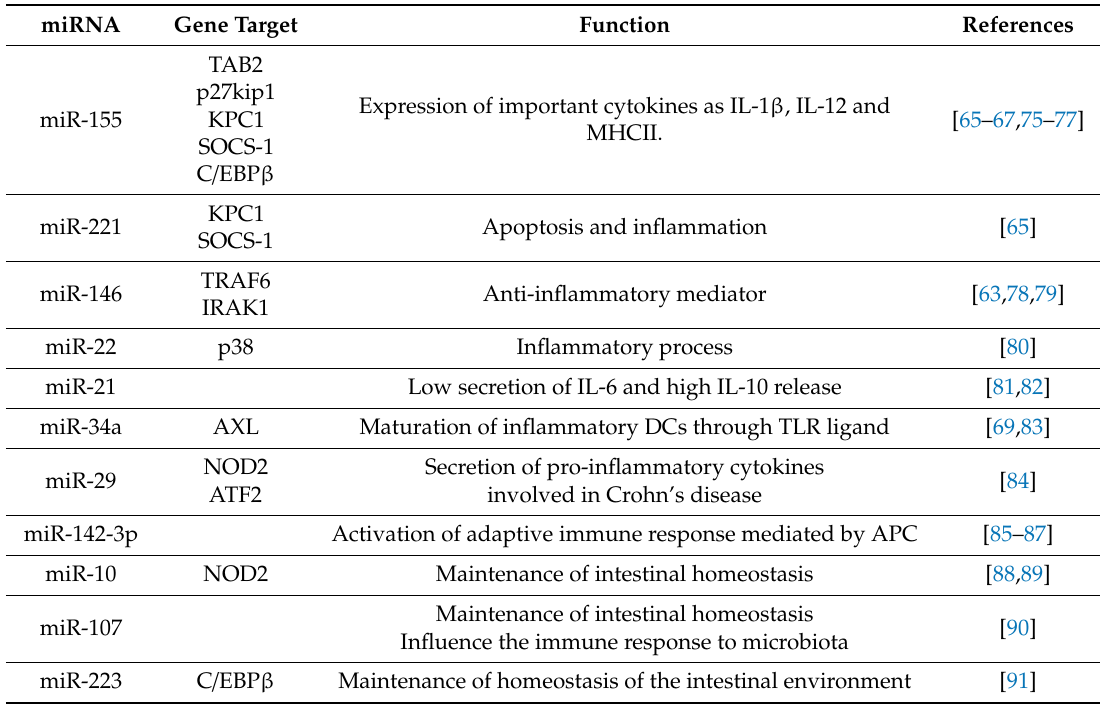
Table 2. miRNAs involved in inflammatory